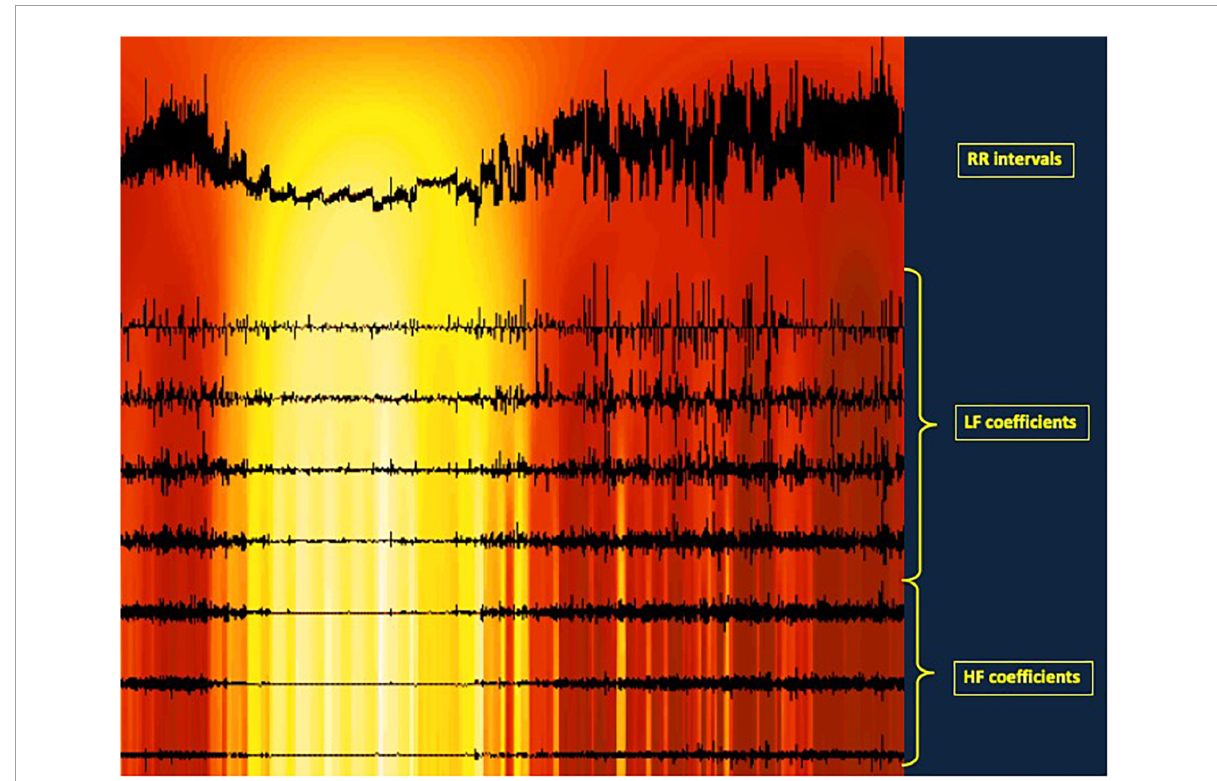
FIGURE1 Illustration of a wavelet analysis for HRV. The upper trace represents the RR intervals length. The seven horirontal lines illustrates the autonomic nervous system activity, the three lowest lines representing he parasympathetic activity, the four upper lines the sympathetic activity. On each horizontal line, a vertical line is traced each time a parasympathetic or a sympathetic activity is detected, i.e., each time the RR length changes at a fast time (HF) or at a slower pace (LF). The additions of these coefficients give the total parasympathetic and sympathetic activity, respectively. In addition, in that experiment, a transient profound artificial aging was induced as a result of intravenous atropine administration at 20-min intervals. That administration shortens progressively th RR intervals. At the same time, the autonomic coefficients representing heart rate variability decrease then disappear. Then they reappear also progressively after the last atropine administration. This illustrates how a wavelet analysis of HRV can measure both the quatitative variations of parasympathetic and sympathetic activity by summing the coefficients along the period analyzed, but can also localize HRV change along the time. The colored background illustrates the ANS activity along the time from high activity in red to low activity in